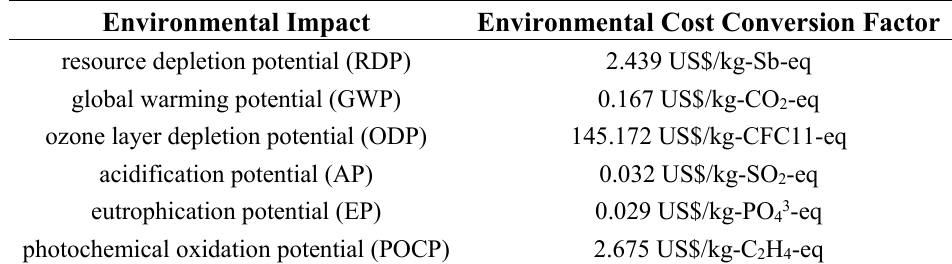
Table A5. Environmental cost conversion factor.